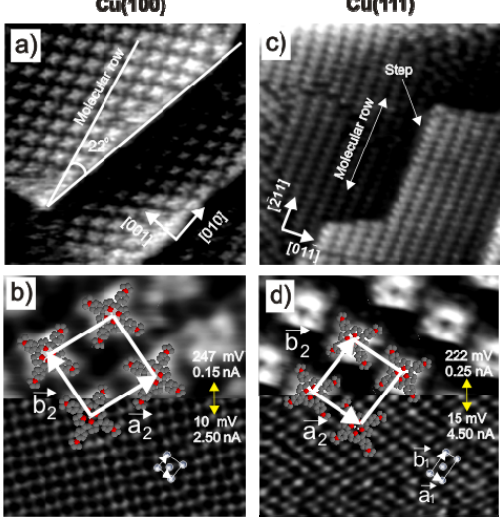
TTMAPP] 4+ Figure 9. Typical medium and high resolution in situ STM images of [H 2 adlayers formed on chloride precovered Cu(100) and Cu(111) electrode surfaces. (Small deviations from the characteristic angle of 90° (120°) between step edges on the Cu(100) (Cu(111)) surface are due to slight drift effects.) A stronger electrostatic interaction between the porphyrin overlayer and the underlying chloride lattice is suggested by the directional coincidence between molecular rows and step edges on the Cl/Cu(111) = 0.1 nA, U = 168 mV, E = +20 mV; ( b ) Upper and substrate. ( a ) 24.42 nm × 24.42 nm, I t b = 0.1 nA, lower half: 7.90 nm × 3.95 nm, E = − 20 mV; ( c ) 33.46 nm × 33.46 nm, I t = 346 mV, E = +50 mV; ( d ) Upper and lower half: 8.10 nm × 4.05 nm, E = +20 U b